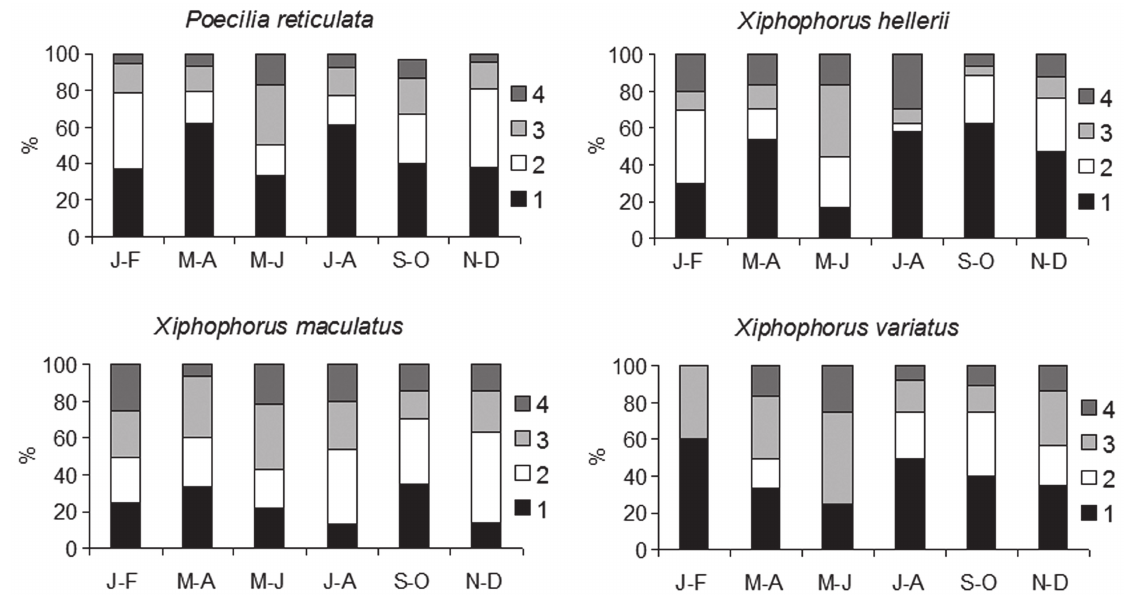
Fig. 3. Relative bimonthly frequency of developmental stages in ornamental non-native poeciliid females collected in Pinheiros Creek, 2004. Developmental stages: 1 Non-gravid, 2 Yolked ova, 3 Eyed embryos, 4 Mature embryos.